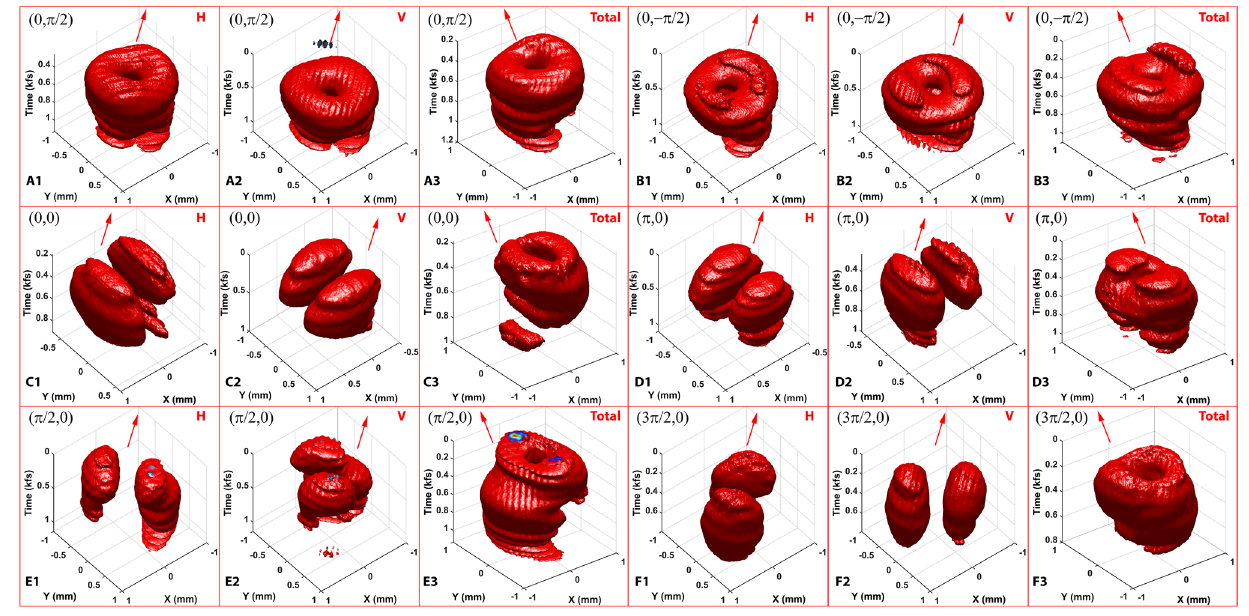
Figure 6. The 3D spatiotemporal reconstruction of pulse electric field E ( r , t ) of six typical HOP SS . ( A) : the north pole state; ( A1 ) and ( A2 ): amplitudes from the H and V channels, respectively; ( A3) : the total amplitude; B : the south pole state; ( C ): the radial state; ( D) : the azimuthal state; ( E) : the state at ( π / 2, 0 ) ; ( F) : the state at ( 3 π / 2, 0 ) . ( B–F) follow the same description as A. The isosurface (red surface) shown is set at 0.4 of the maximum